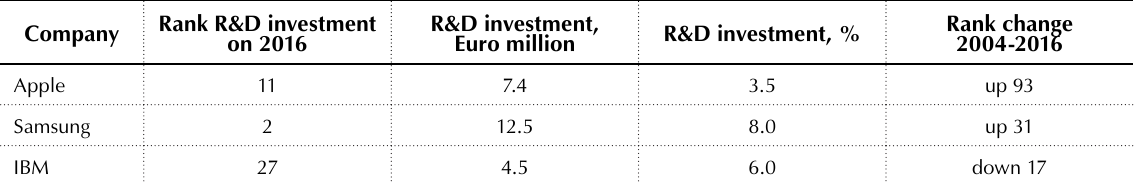
Table 2. Ranking of the companies by R&D investment in 2016